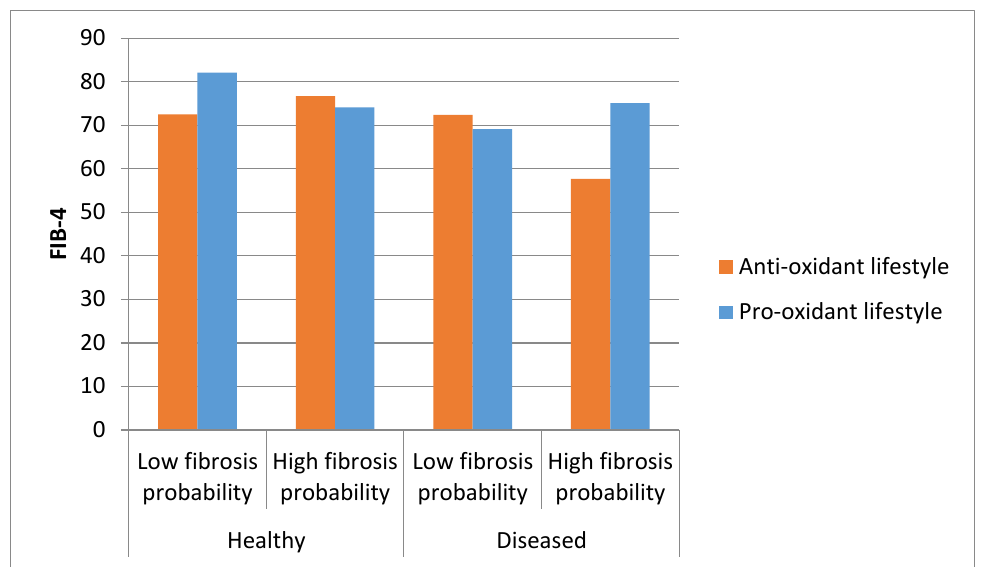
Figure 2. Interaction between comorbidity, liver fibrosis probability according to FIB-4 and oxidative lifestyle in the prediction of QoL. QoL assessed by the mean of all 8 categories in SF-36; Low fibrosis probability: p < 50 of FIB-4; High fibrosis probability: p > 50 of FIB-4; Anti-oxidant lifestyle: 0 or 1 oxidative factors; Pro-oxidant lifestyle: 2 oxidative factors; Diseased: 1 or more co-morbidities. p for interaction between comorbidity, liver fibrosis and oxidative lifestyle <